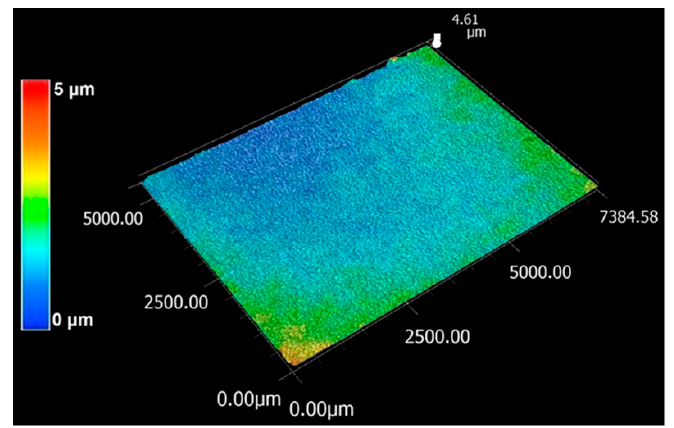
Figure 2. 3-dimensional LM image of the AA6014 aluminum alloy test plate